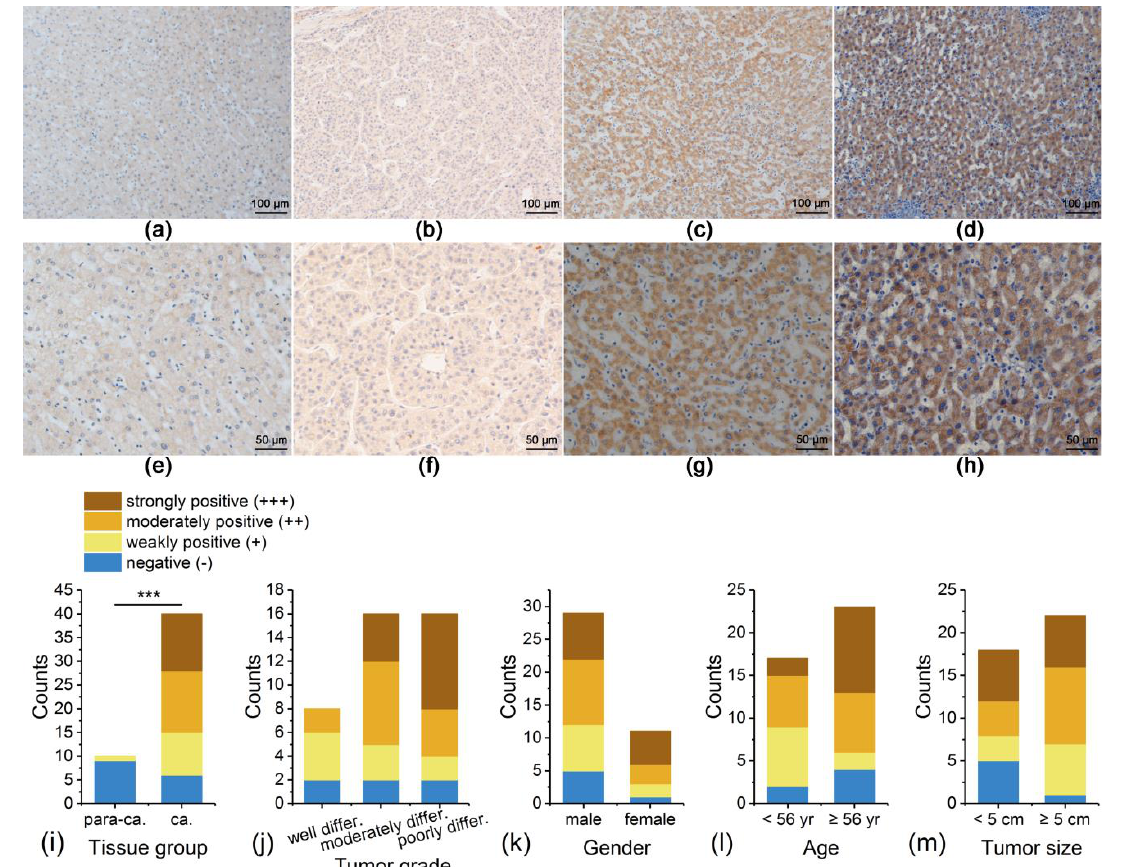
Figure 4. Typical immunohistochemistry staining for IRAK1 expression in the liver tissues from clinical specimens of patients with hepatocellular carcinoma. ( a , e ) Para-carcinoma tissue, negative (−); ( b , f ) well differentiated tumor tissue, weakly positive (+); ( c , g ) moderately differentiated tumor tissue, moderately positive (++); ( d , h ) poorly differentiated tumor tissue, strongly positive (+++). The magnifications for panels ( a – d ) are ‘×100′ , and those for ( e – h ) are ‘×200′ ; ( i – m ) the distribution of counts of different staining in tissue groups, tumor grades, genders, ages, and tumor sizes. Statistical significance was evaluated based on the total positive rate, taking (+), (++), and (+++) into consideration. For tissue group, it was p < 0.001 (***). Others were not significant ( p > 0.05).